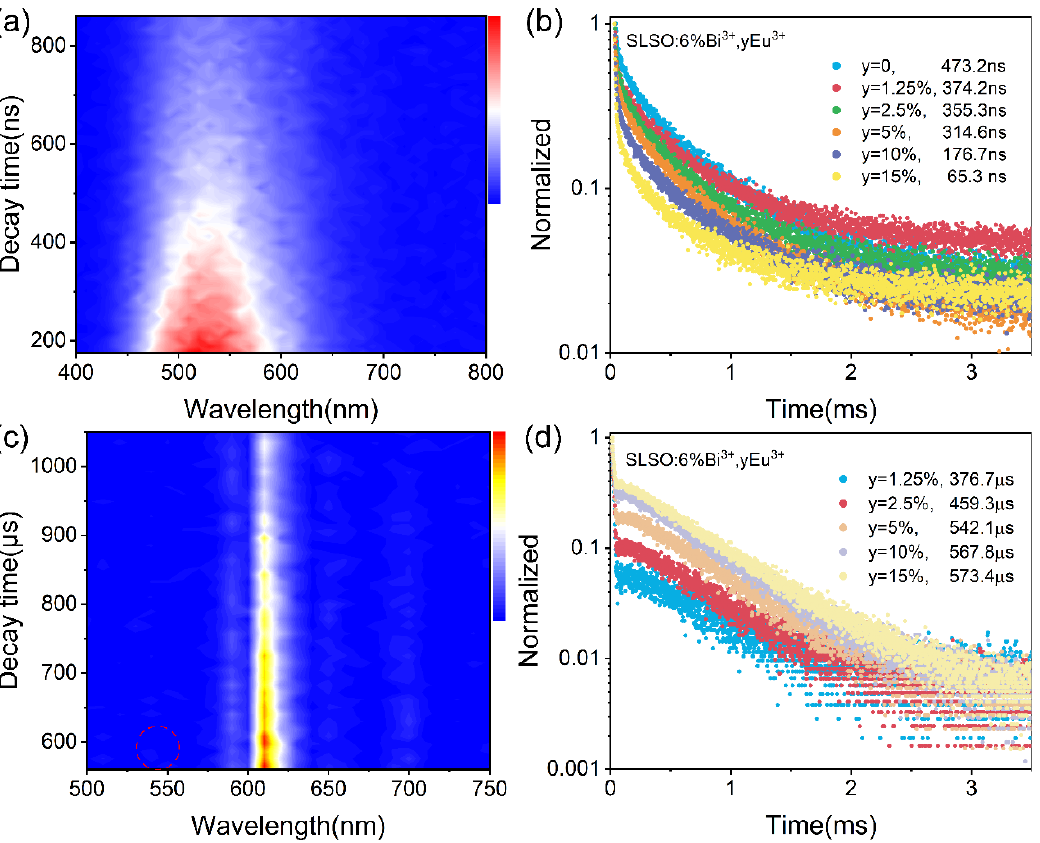
Figure 3. ( a , b ) Time-resolved spectrum and fluorescence decay curve of Bi 3+ ; ( c , d ) time-resolved spectrum and fluorescence decay curve of Eu 3+ in SLSO: Bi 3+ , y Eu 3+ .